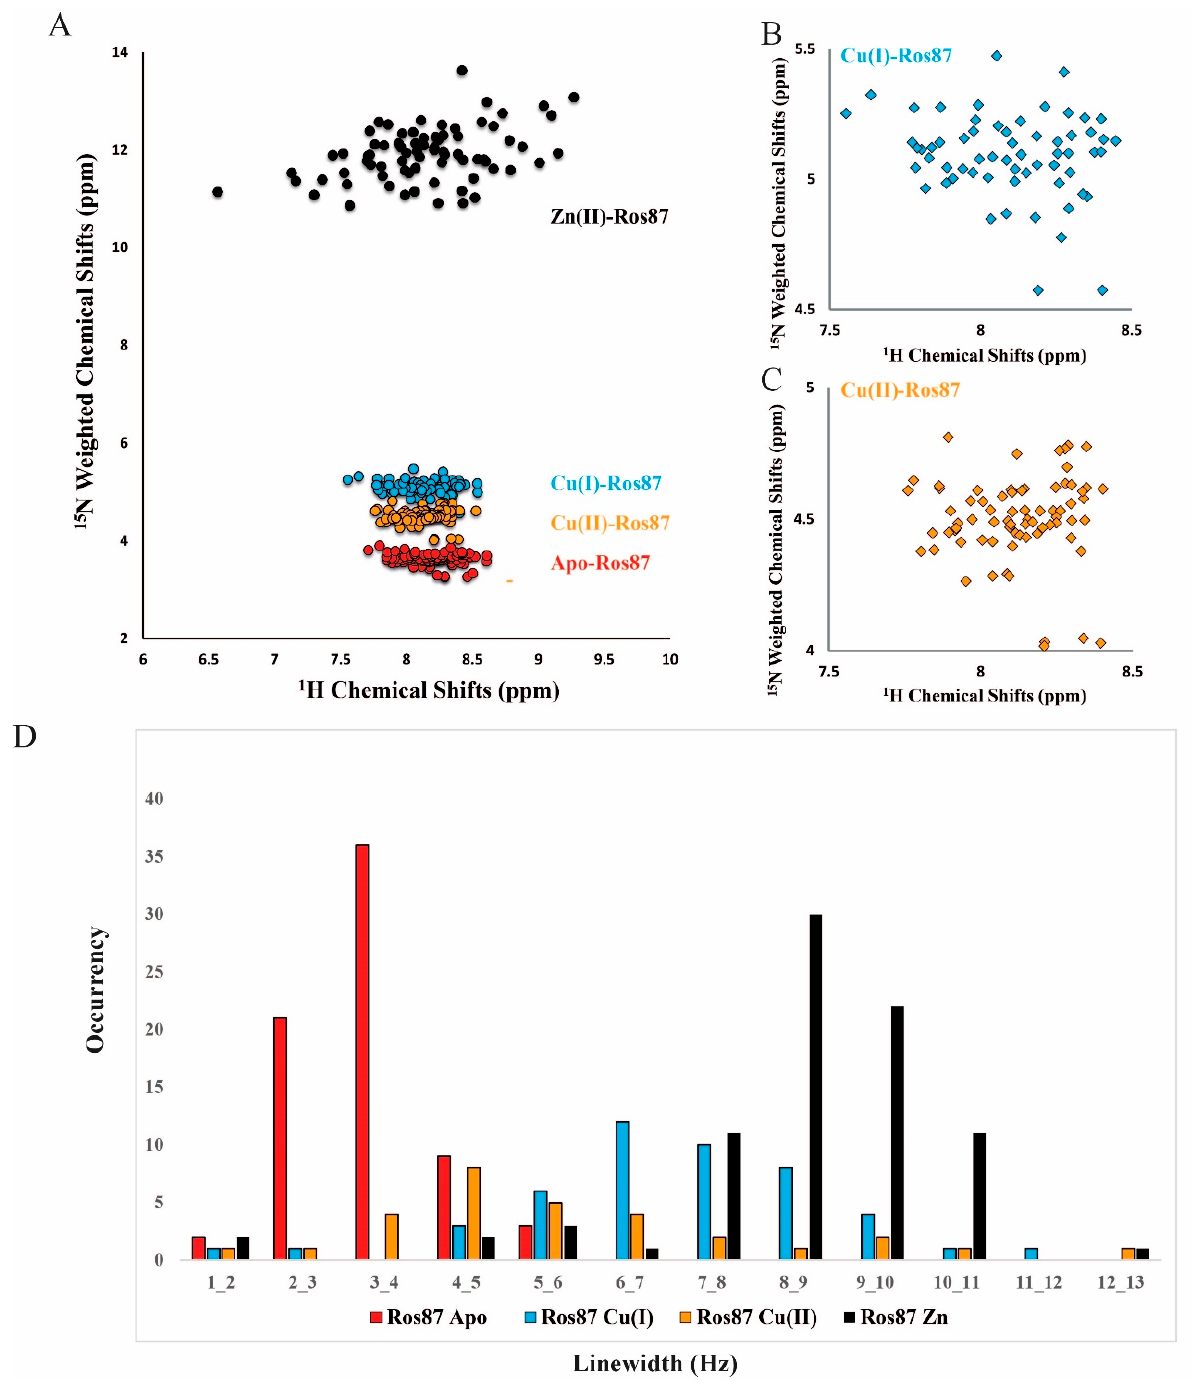
Figure 5. Chemical shift analysis. ( A ) Correlation plots of the 15 N-weighted and 1 H chemical shifts for Apo-Ros87 (red), Cu(I)-Ros87 (blue) and Cu(II)-Ros87 (light green). Close view of the 15 N- weighted/ 1 H shifts plots obtained for ( B ) Cu(I)-Ros87 and ( C ) Cu(II)-Ros87. ( D ) Analysis of relaxation rates R2 for Apo-Ros87 (red), Cu(I)-Ros87 (blue), Cu(II)-Ros87 (light green) and Zn-Ros87 (black).